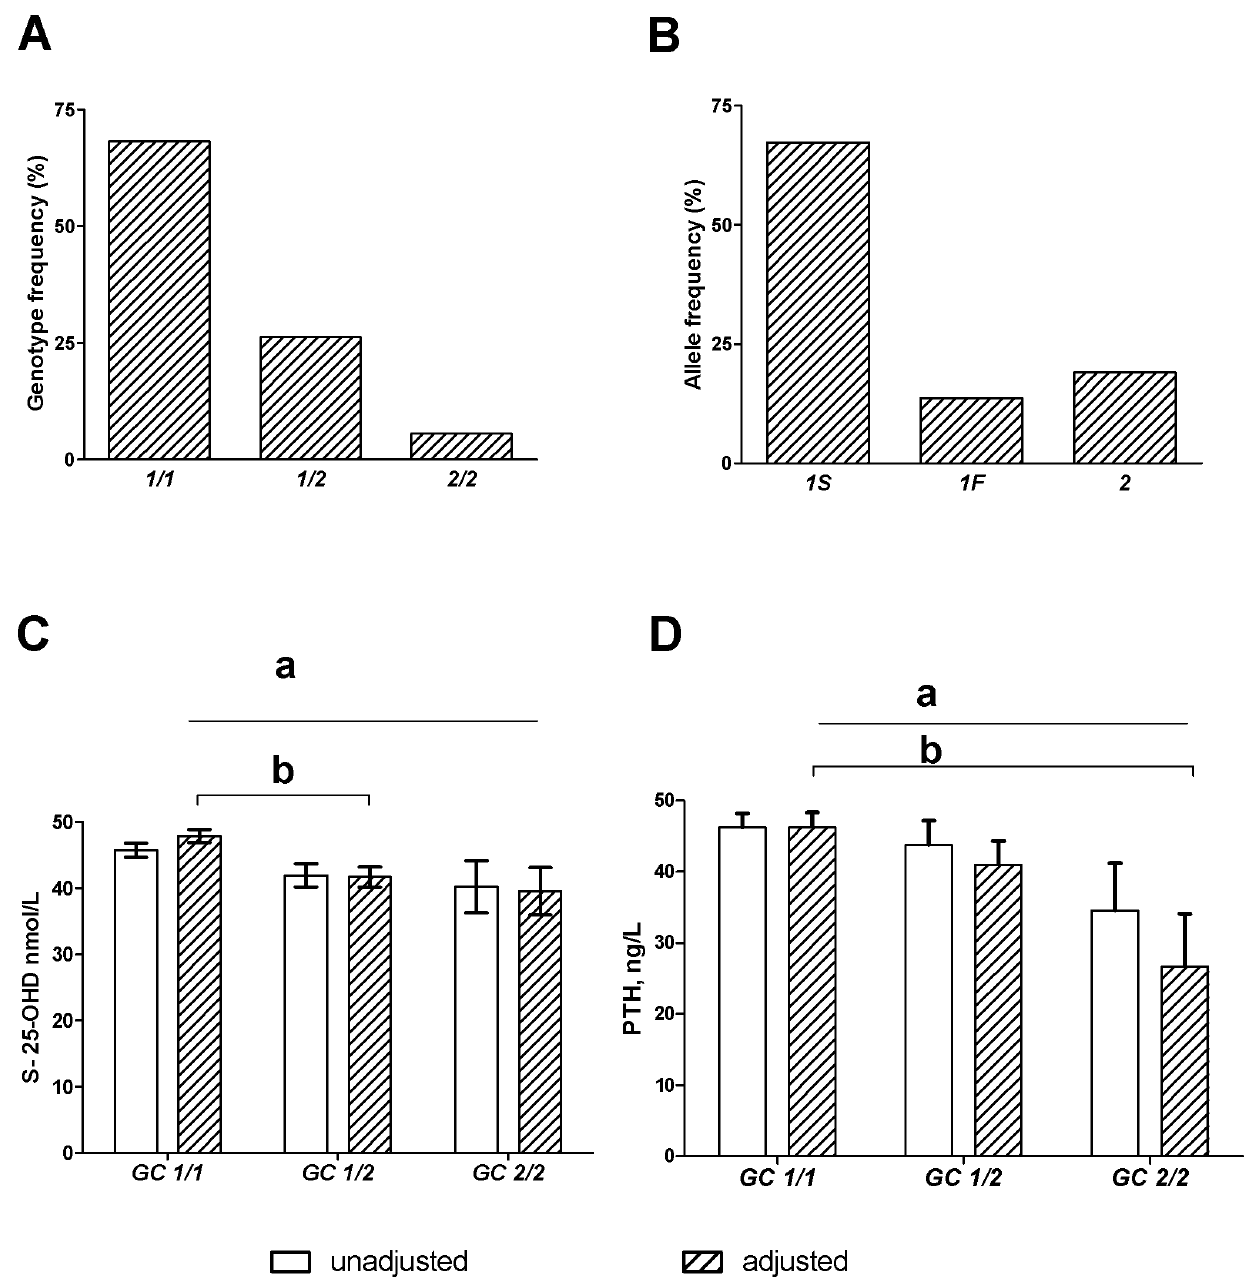
Figure 1. The distribution of GC genotypes and alleles in the study population, and associations among 25(OH)D, PTH and GC genotypes. ( A ) Distribution of GC genotypes 1/1 , 1/2 and 2/2 among the subjects (N=159, 61 and 13 respectively). B ) Distribution of GC alleles among the subjects (N=187 and 44 respectively). ( C ) Association of GC genotype with S-25(OH)D concentrations. Results are shown for mean ( 6 SE) unadjusted values (ANOVA; p=0.102, N=158, 59 and 12, respectively) and mean ( 6 SE) values after adjustment for vitamin D intake, PTH, group 1 or 2, and month when blood sample was taken (ANCOVA; ( a ) p=0.001, N=154, 59 and 12). S-25(OH)D concentration was highest in GC 1/1 and lowest in GC2/2. A significant difference were present in S-25(OH)D concentrations between GC 1/1 and GC 1/2 (ANCOVA; ( b ) p=0.003). There was a negative linear trend between the genotypes (p=0.025). ( D ) Association of GC genotype with PTH concentrations in group 1. Results are shown for mean ( 6 SE) unadjusted values (ANOVA; p=0.227, N=125, 42 and 11 respectively) and mean ( 6 SE) values after adjustment for calcium intake, S-25(OH)D, and month when blood sample was taken (ANCOVA; ( a ), p=0.028, N=98, 37 and 8 respectively). PTH levels were highest in GC 1/1 and lowest in GC 2/2 ( ANCOVA; (b) p=0.036 ). There was a negative linear trend among the genotypes (ANCOVA; p=0.012). doi:10.1371/journal.pone.0087292.g001 66% proximally from the distal end of the non-dominant radius as described in detail previously [29]. The scans were analyzed using geometry were measured from the non-dominant radius with version 5.50 of the manufacturer’s software package in which the pQCT (XCT-2000; Stratec, Pforzheim, Germany) in a group of outer contour of bone is defined with threshold of 280 mg/cm 3 . 175 subjects (104 girls and 71 boys, part of group 1), at the 4% and